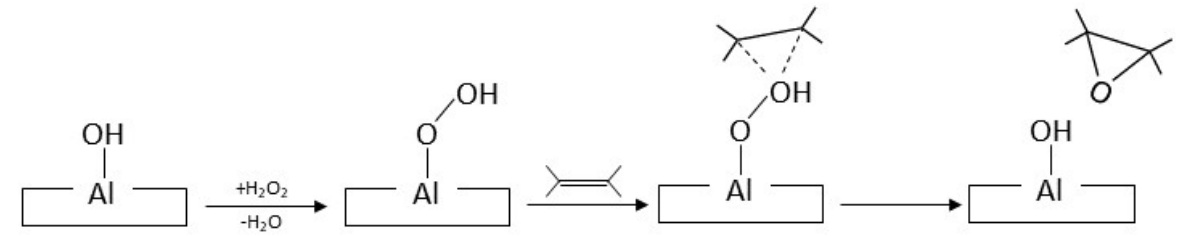
Figure 2. Mechanism of olefins epoxidation by alumina in the presence of hydrogen peroxide [4].